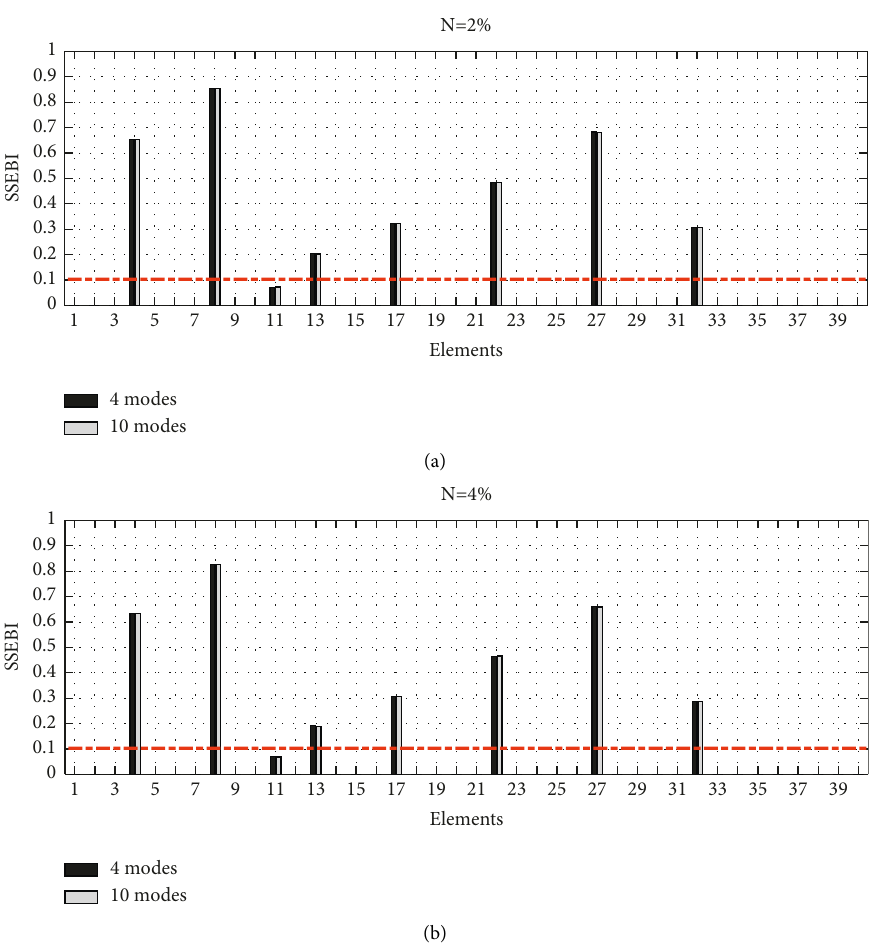
Figure 2: Damage detection results for the 40-element beam, the first step; (a) damaged locations, 2% noise, (b) damaged locations, 4% noise in measured natural frequencies.